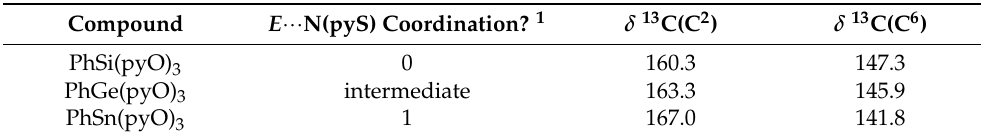
Table 2. 13 C NMR shifts of C 2 and C 6 of the pyridine-2-olate (pyO) ligands of compounds Ph E (pyO) 3 in CDCl 3